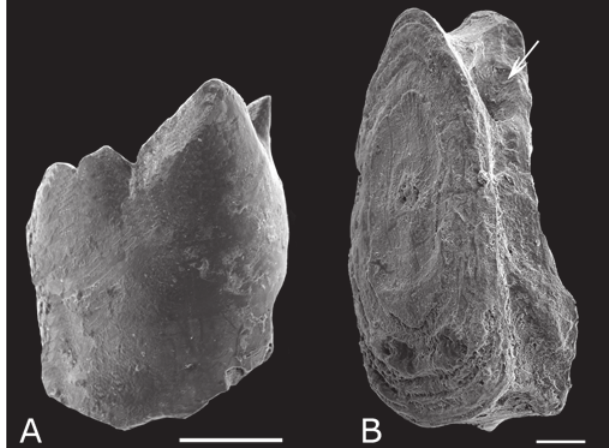
Fig. 4 . † Bryconetes enigmaticus n. gen. n. sp., holotype, UFRGS 19114. A, a dentary tooth. B, first vertebra of Weberian apparatus. Arrow points to the facet for reception of scaphium. Scale bars = 200